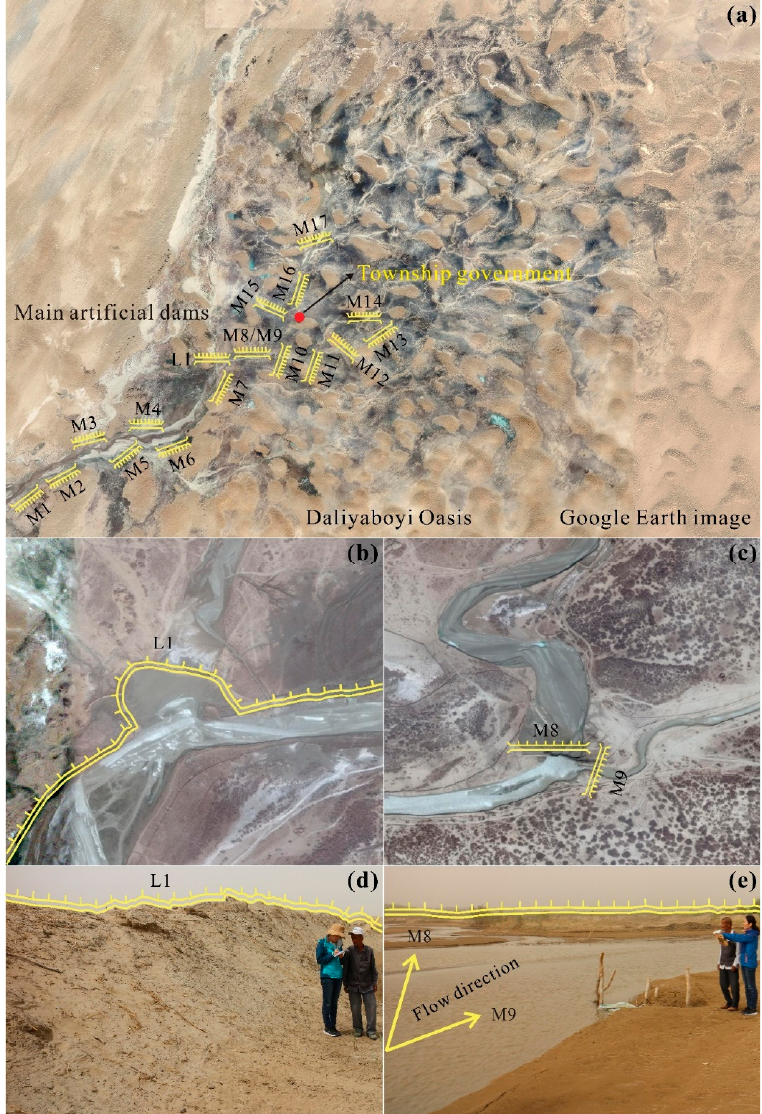
Figure 8. ( a ) Distribution of the main artificial dams in the Daliyaboyi Oasis; ( b , d ) are a Google Earth image and field photograph of the dam at L1, respectively; ( c , e ) are a Google Earth image and field photograph of the dams at sites M8 and M9,